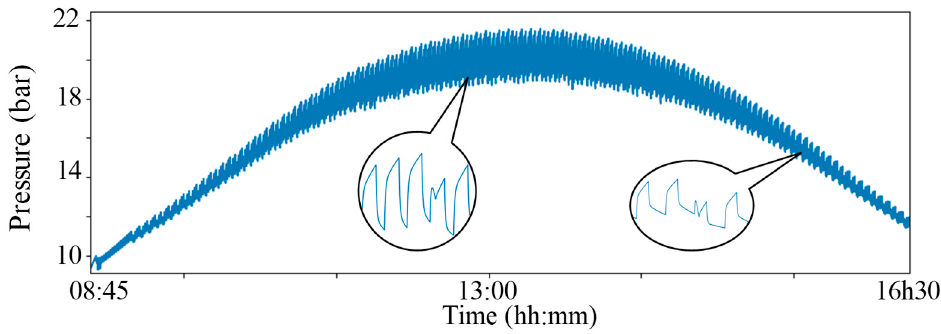
Figure 19. Simulated evaporator pressure over a sunny day.